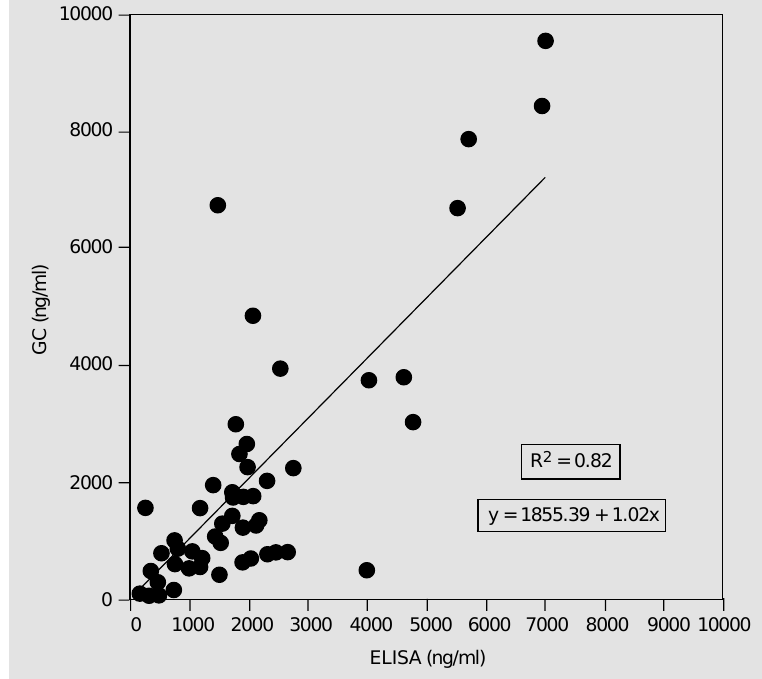
Figure 1. Regression curve between the gas chromatography (GC) and ELISA methods used to quantify caffeine in human plasma, in ng/ml.